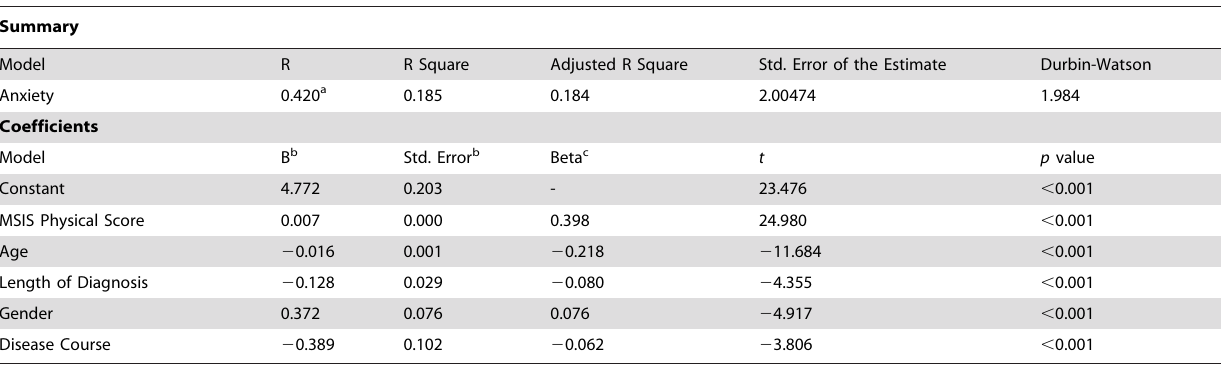
Table 2. Multiple Regression Coefficients for MSIS Physical Score for Anxiety.